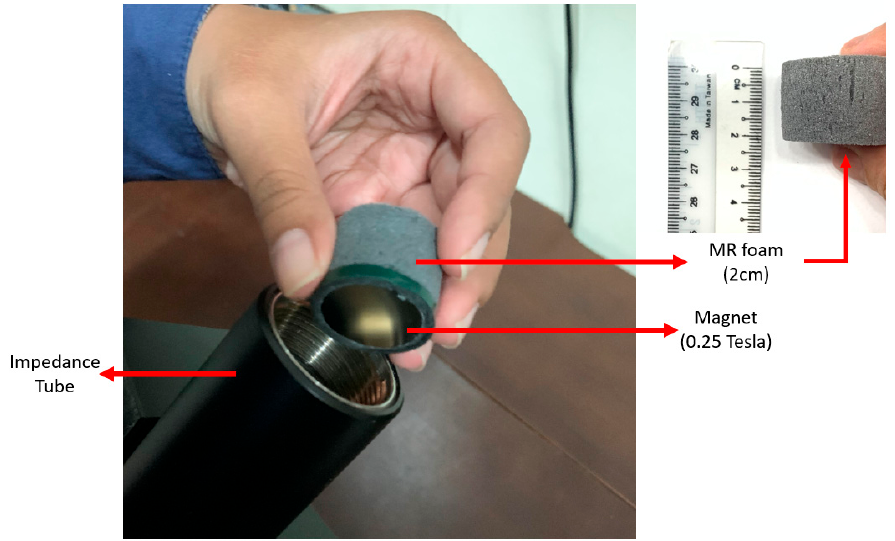
Figure 2. Tunable sound absorption setup.